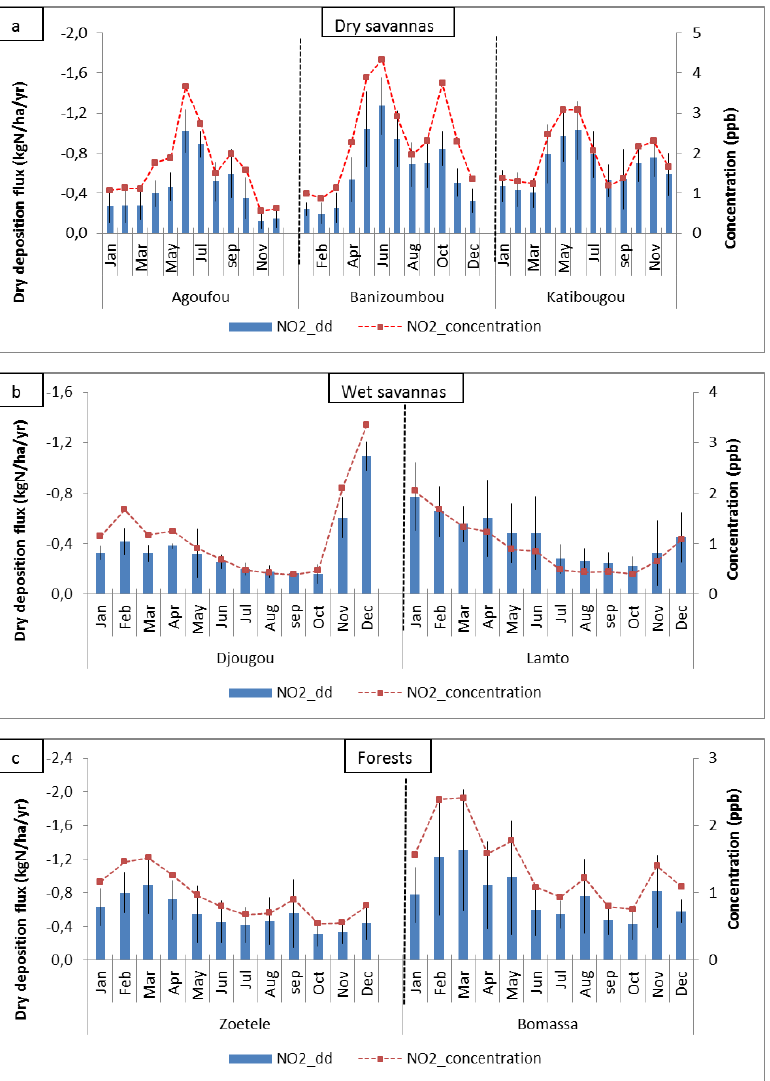
Fig. 5. Evolution of monthly dry deposition fluxes of NO 2 (NO 2 _dd) in kgNha − 1 yr − 1 (1998–2007) on the transect dry savannas (a) , wet savannas (b) and forests (c) associated with evolution of NO 2 concentrations